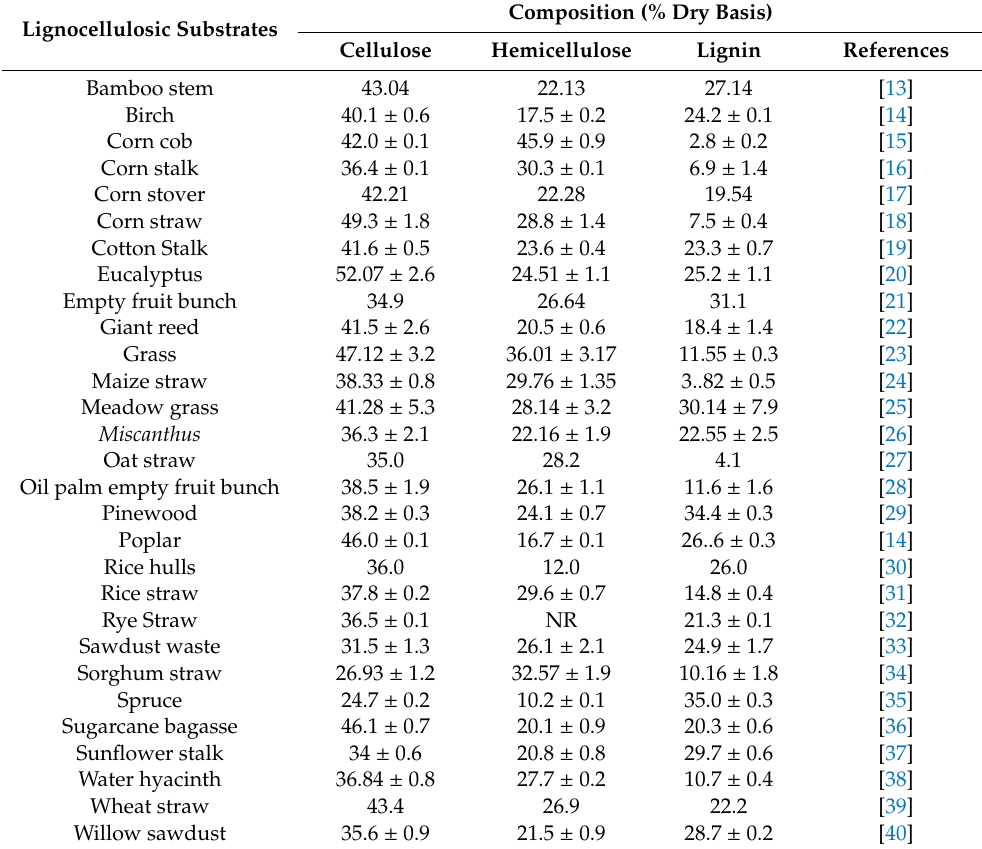
Table 2. Composition of different lignocellulosic substrates; cellulose, hemicellulose, and lignin content (%) on dry basis.